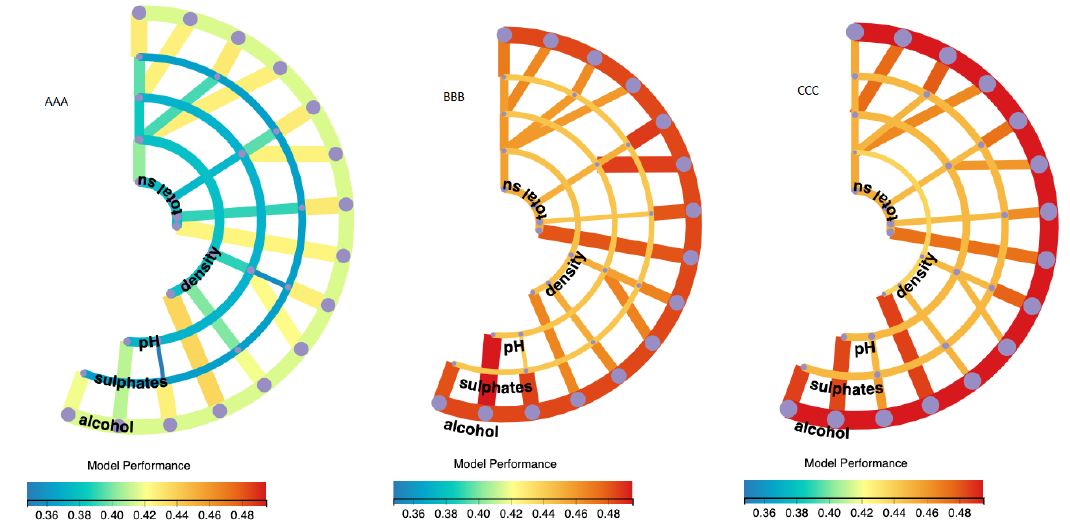
Figure 6. Comparison of three ML algorithms for the same data set with RadialNet. Reprint with permission from Jianlong Zhou, Weidong Huang and Fang Chen (2020). Copyright 2020 IEEE Pacific Visualization Symposium